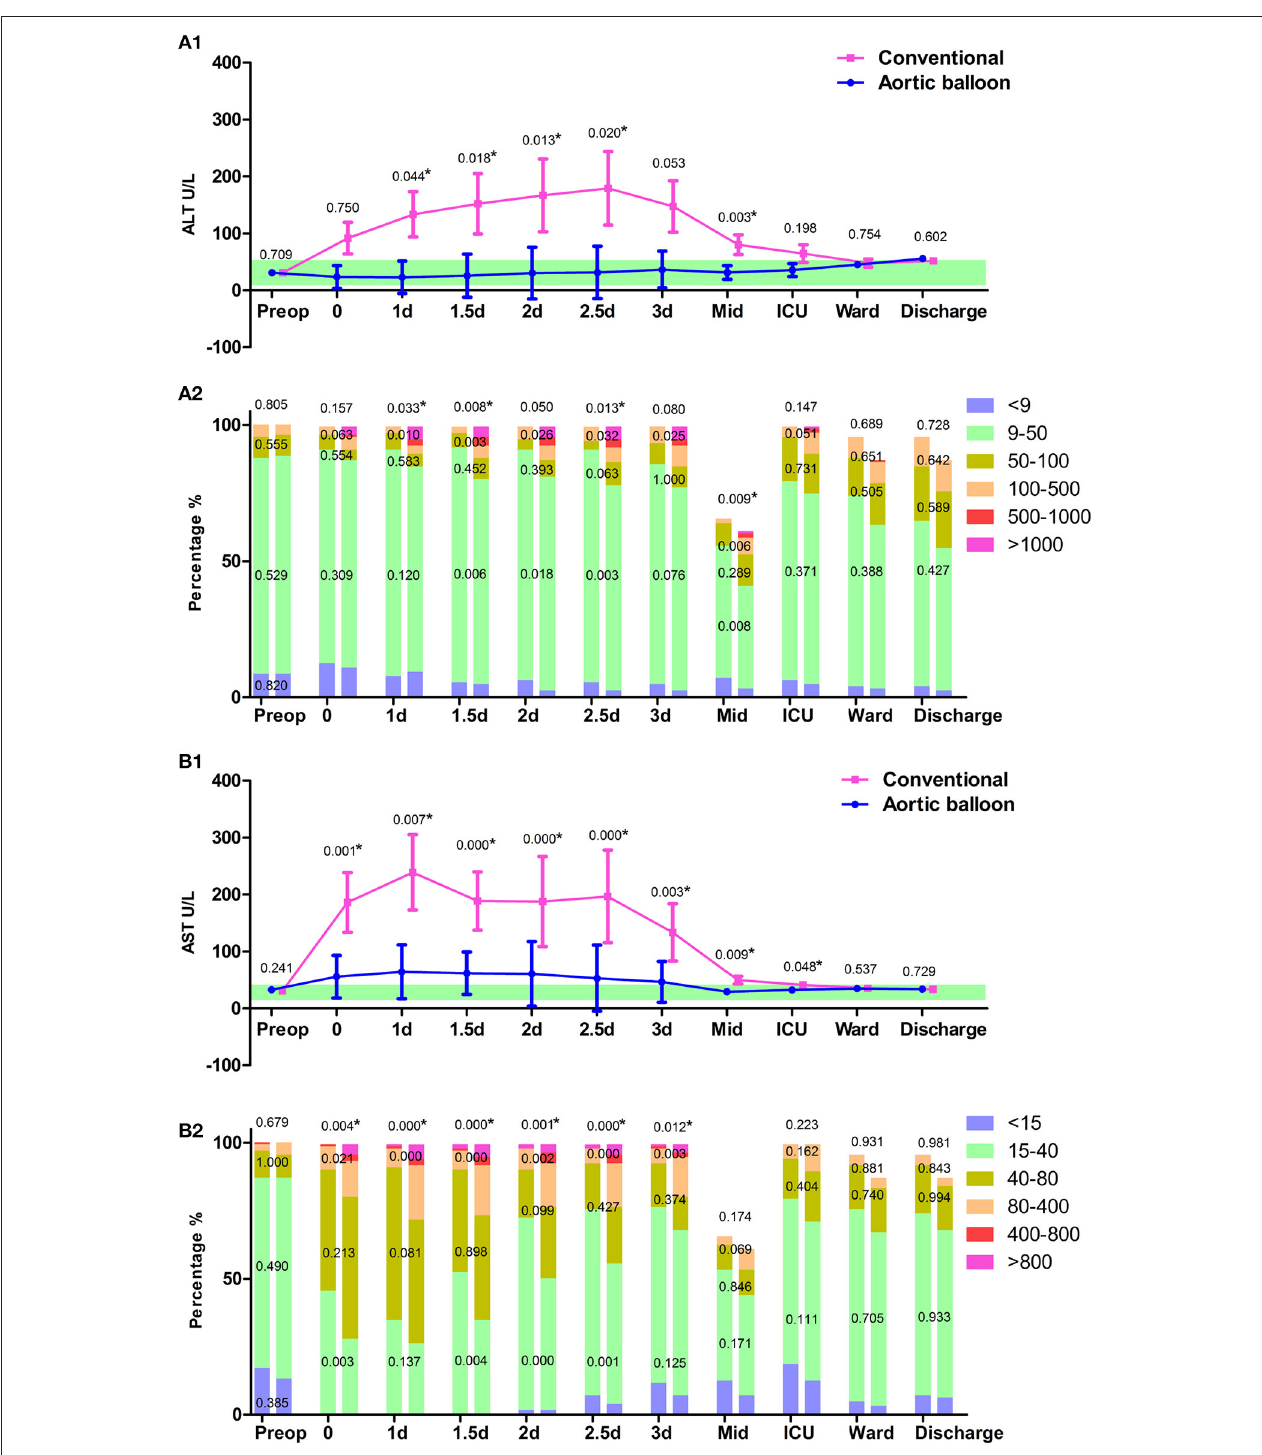
FIGURE 5 | Hepatic function. (A1) The trajectory of alanine transaminase (ALT). (A2) ALT grading in the column. (B1) The trajectory of aspartate transaminase (AST). (B2) AST grading in the column. Data points are represented by mean with a standard error of mean bars. * P < 0.05.